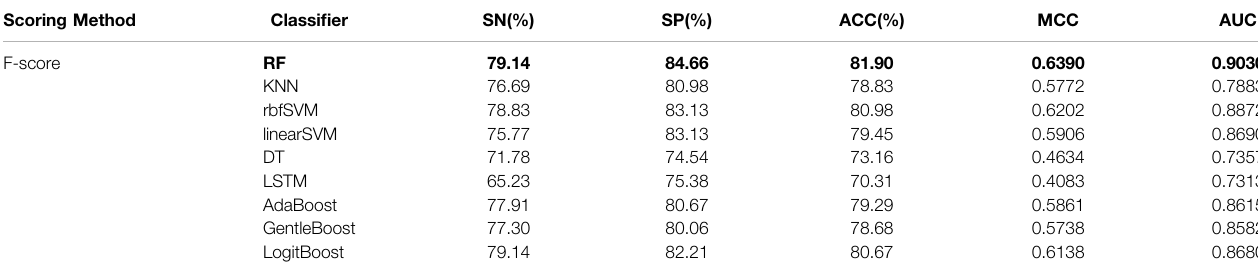
TABLE 2 | The prediction performances of different classi fi ers in nested fi ve-fold cross-validation. Scoring Method